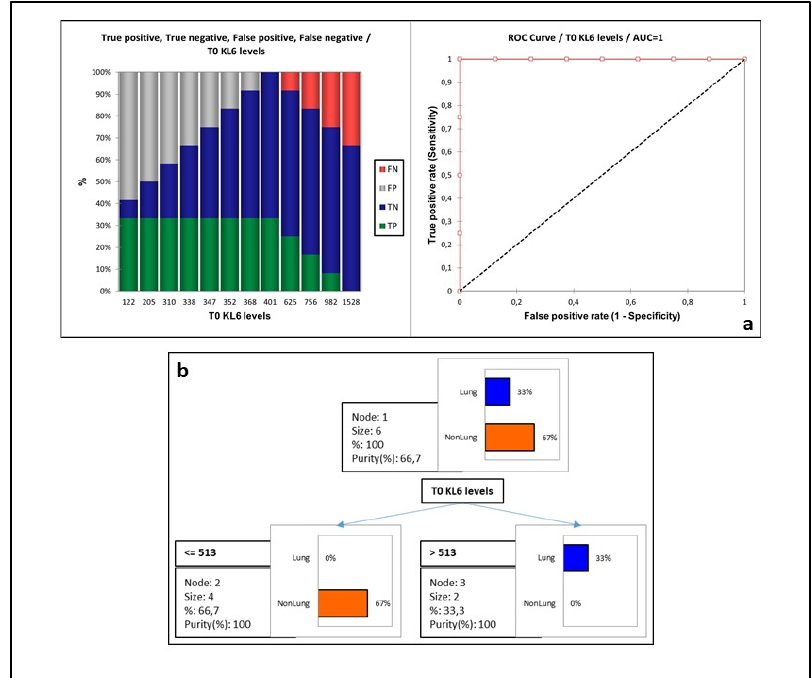
Figure 1. ( a ) Receiver operating characteristic (ROC) curves were first employed to analyze the diagnostic performance of KL-6 for identifying the ILD involvement and to select the best cutoff threshold with high sensitivity and specificity. ( b ) Decision tree model obtained using KL-6 concentrations at T0 showed a 33% improvement in class purity using a cut-off value of 513 U/mL to distinguish AAV patients with and without ILD ( p = 0.034). Lung and non-lung are referred to the presence and absence of ILD, respectively. Abbreviations: TP, true positive; TN, true negative; FP, false positive; FN, false negative.